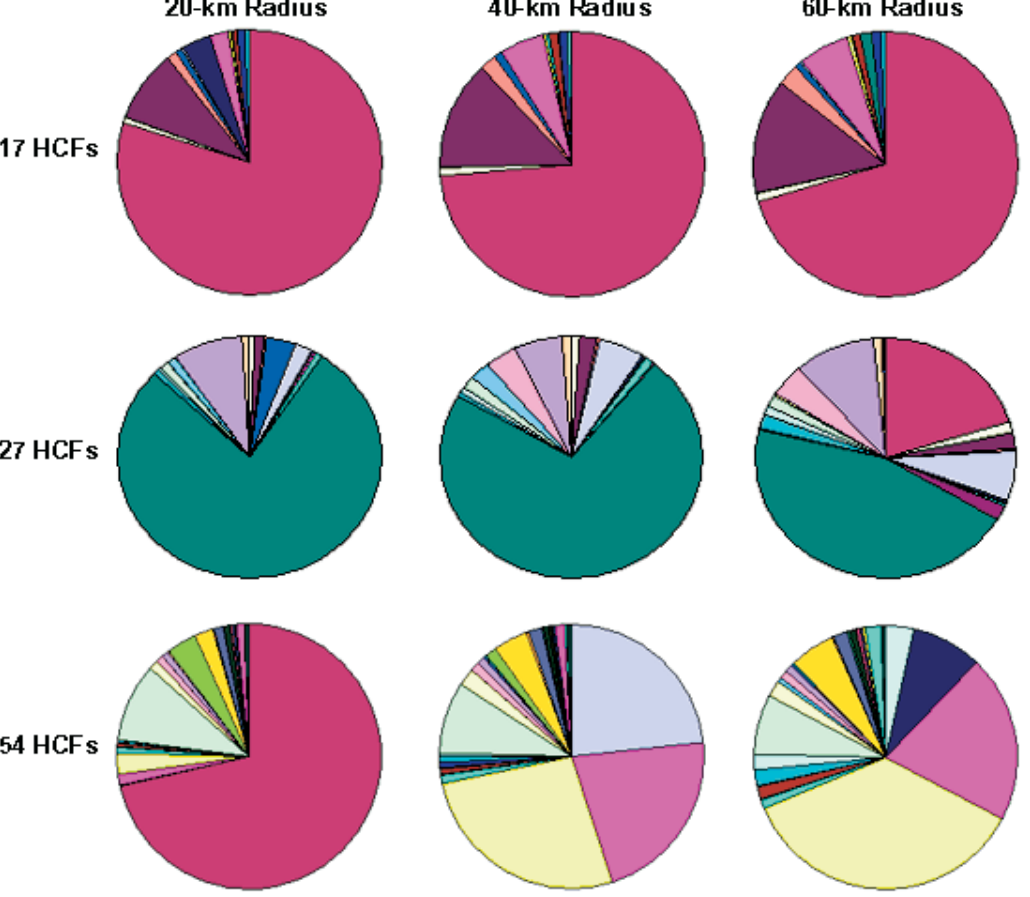
Figure 5. Actual Allocation of ARVs to HCFs These pie charts show ARV allocation to HCFs according to our model and optimization for the cases of 17 , 27 , and 54. The allocation is shown for each of the catchment region sizes considered: 20-km radius, 40-km radius, and 60-km radius. DOI: